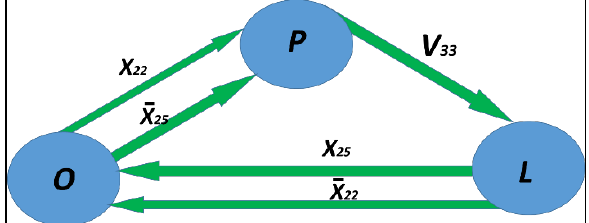
Figure 10. Automatic graph of the valve